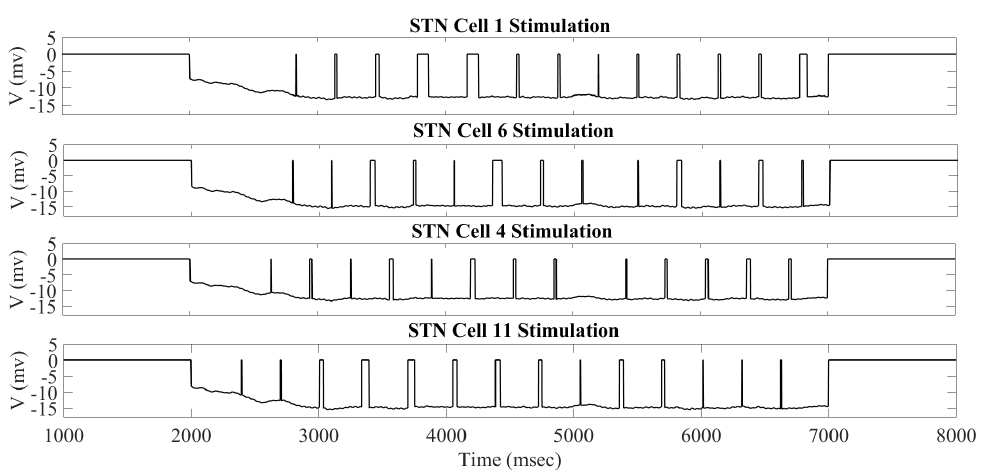
Figure 8. Adaptive local field potential stimulation delivered to STN Cells 1, 4, 6, and 11 arranged by the synchronous group during the time window of 2000 to 7000 ms. Note that the top part of the curve represents the time when the stimulation is turned off, while the bottom part of the curve is when the stimulation is turned on.